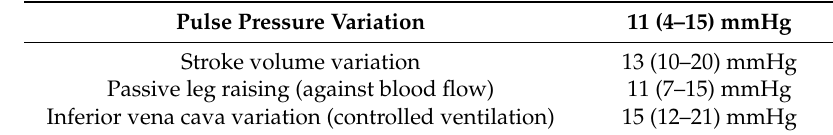
Table 2. Cut off and “grey zone” for main